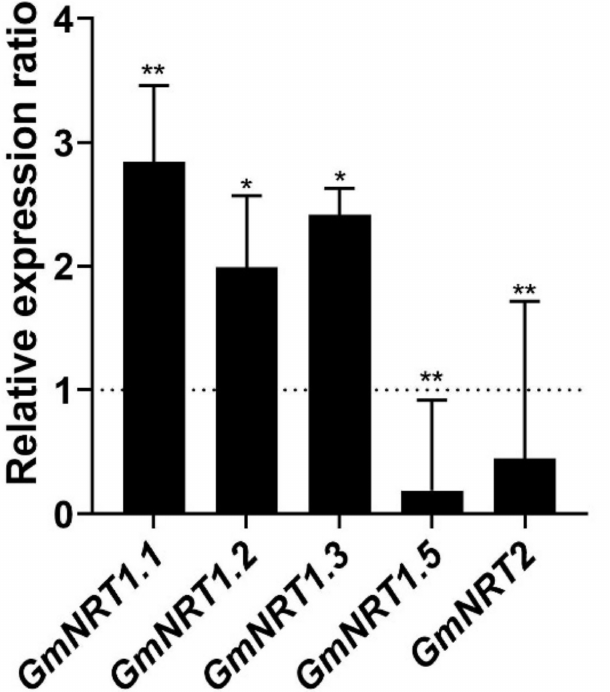
Figure 8. Relative expression ratio of NRT genes from the GmCEP-XSP1ox line to the control line in soybean hairy root tissues. The error bars indicate standard deviation ( n = 4). The expression level is relative to the control hairy root (empty vector). Significant difference was analyzed by Student’s t -test (*= p -value < 0.05, ** = p -value <